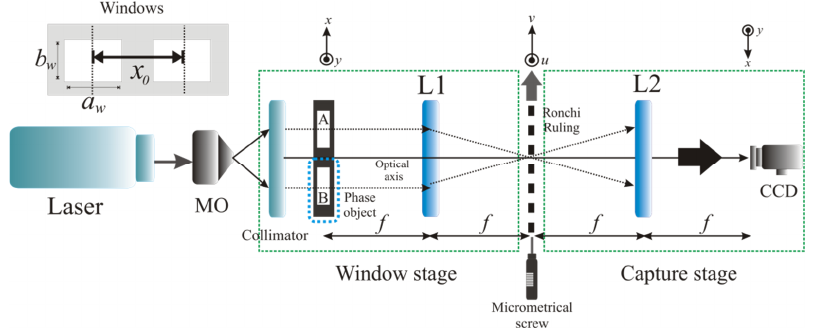
Figure 1. Schematic of a DACPI; MO: Microscope Objective, CCD: Charge-Coupled Device camera. The field from the object plane is propagated through (cid:1838) (cid:2869) , then, in the ruling plane, the field is formed by the interfered diffraction orders from both window fields. Consid- ering the impulse response of the spatial filter, the rectangular function for the windows at the image plane (capture stage) is expressed by (cid:1875)((cid:1876),(cid:1877)) = rect((cid:1876) (cid:1853) (cid:3050) )⁄ rect((cid:1877) (cid:1854) (cid:3050) )⁄ , and the phase difference between the probe and the reference arm is (cid:2038)((cid:1876),(cid:1877)) = (cid:2038)((cid:1876),(cid:1877)) (cid:3019) − (cid:2038)((cid:1876),(cid:1877)) (cid:3017) . The interference pattern due to the superposition of fields from the 0th order of the probe arm and the 1st order of reference arm can be described as in [18,29]: (cid:1835) (cid:2868)(cid:3037) ((cid:1876),(cid:1877)) = (cid:2869) (cid:3095) (cid:3118) (cid:1827) (cid:3019) (cid:2870) + (cid:2869) (cid:2872) (cid:1827) (cid:3017) (cid:2870) + (cid:2869) (cid:3095) (cid:1827) (cid:3019) (cid:1827) (cid:3017) cos(cid:3435)(cid:2038)((cid:1876),(cid:1877)) − (cid:2009) (cid:3037) (cid:3439) ,